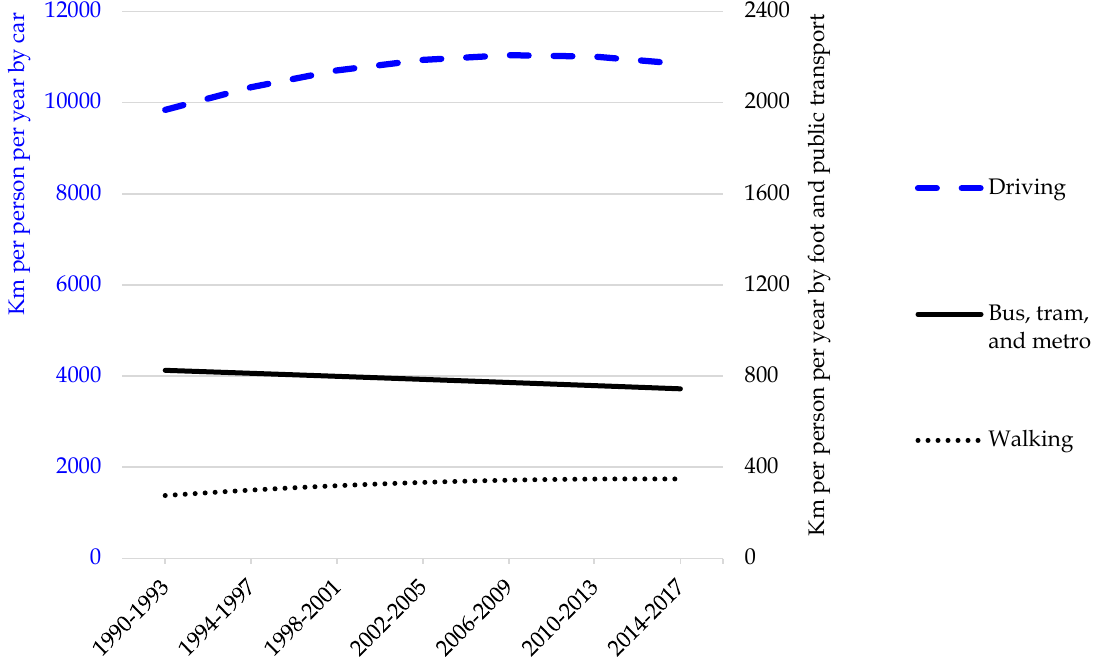
Figure 7. The development of distance travelled per capita per year on foot, by public transport (bus, tram, and metro), and by car between 1990 and